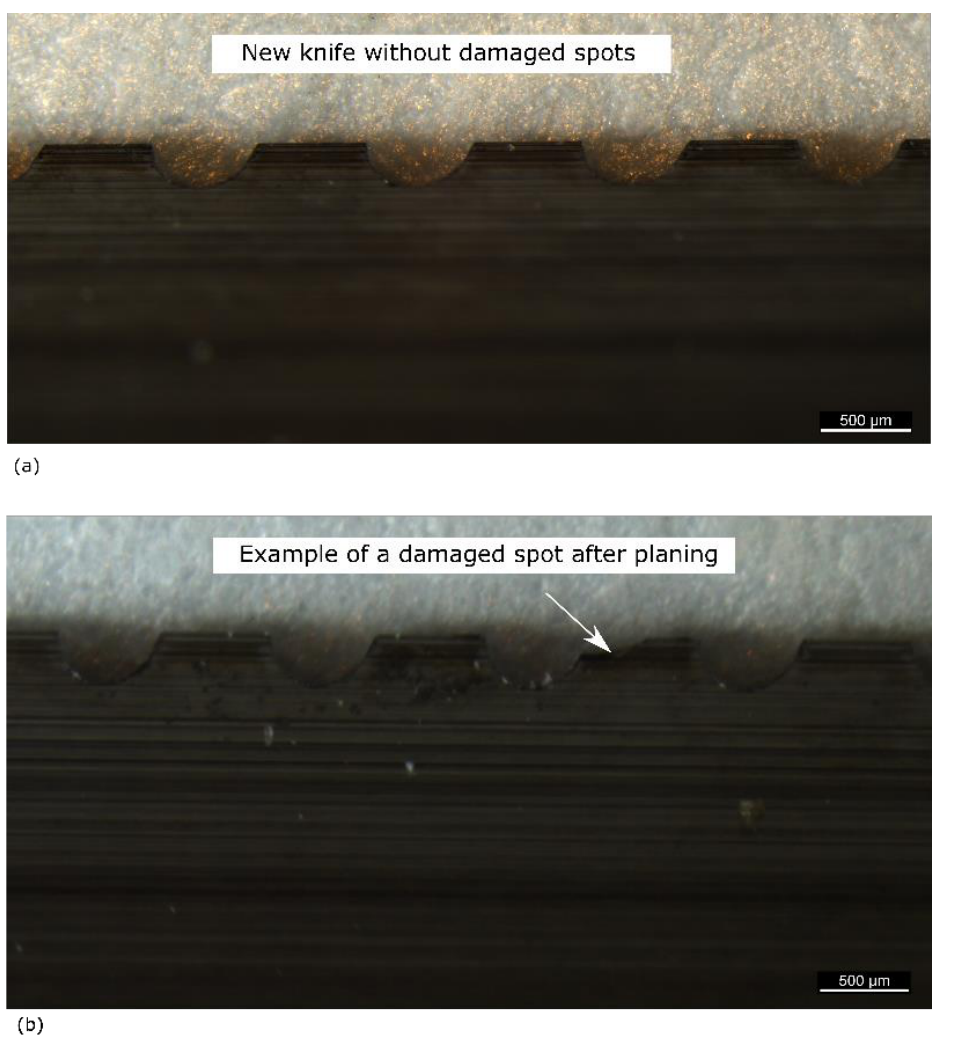
Figure 9. Comparison of a new knife ( a ) with a knife with located wear ( b ).